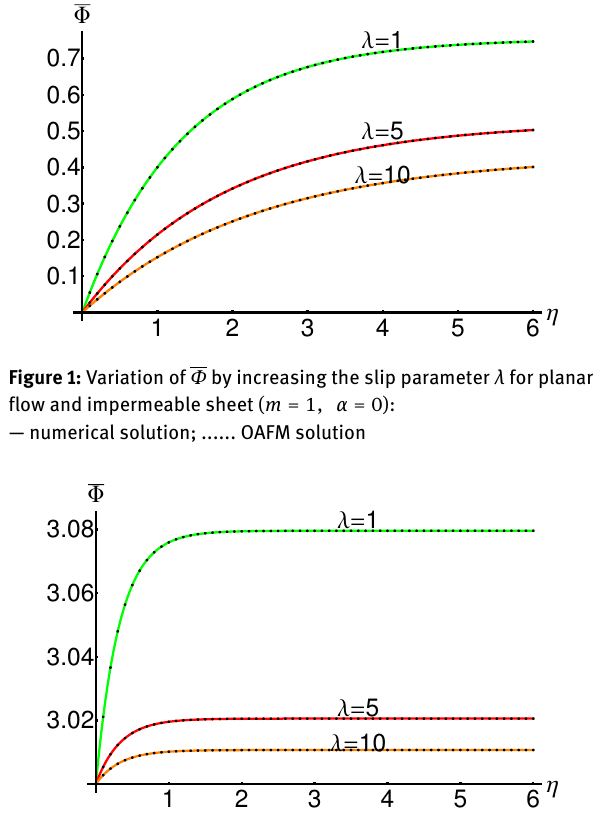
Figure 2: Variation of Φ by increasing the slip parameter λ for planar flow and suction sheet ( m = 1, α = 3) : — numerical solution; ...... OAFM solution